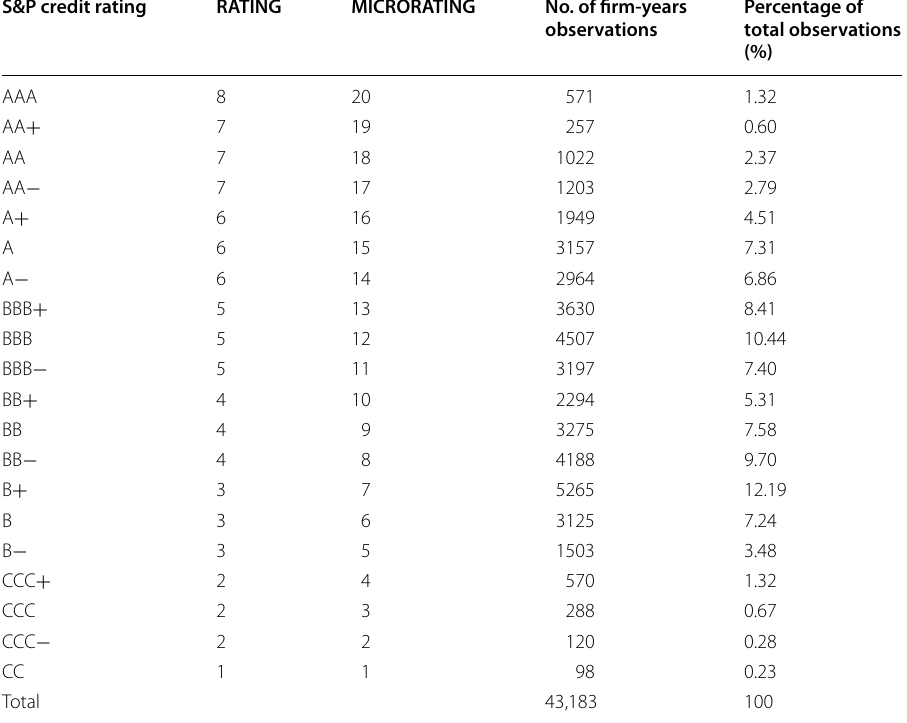
Table 1 Credit rating